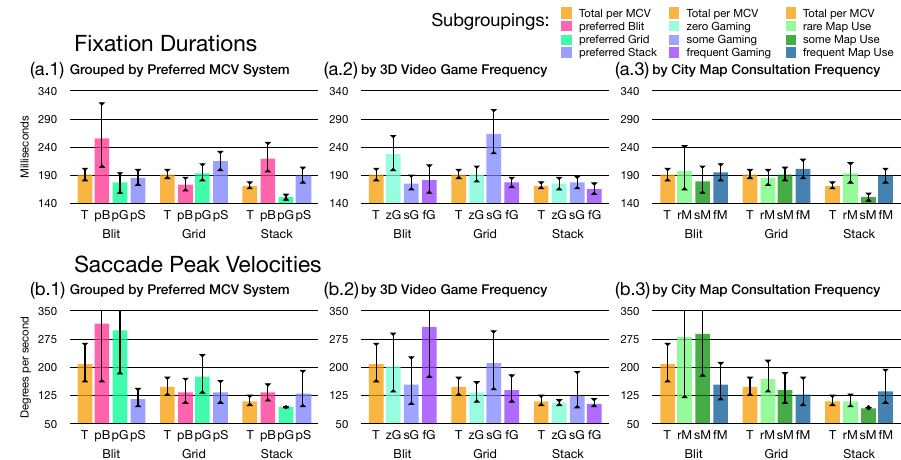
Figure 11. Further visuo-motor behavior measurements for each MCV system (blit/grid/stack): the average fixation durations between saccades ( a ), and the average peak velocities reached during saccades ( b ) (upper confidence intervals cut to increase legibility of smaller values). Further subgrouped by the participants’ preference for an MCV system regarding its legibility (1), the frequency with which they play video games (2), and the frequency with which they consult city maps